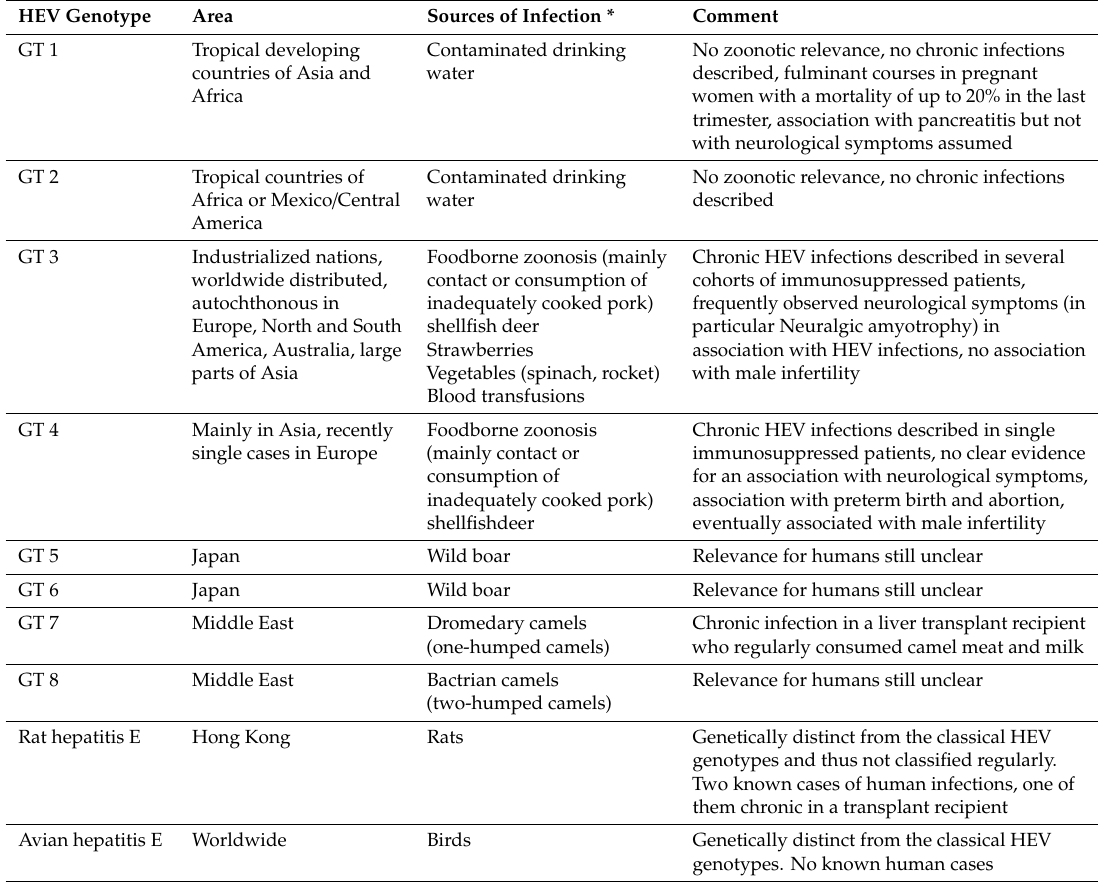
Table 1. Hepatitis E virus (HEV)